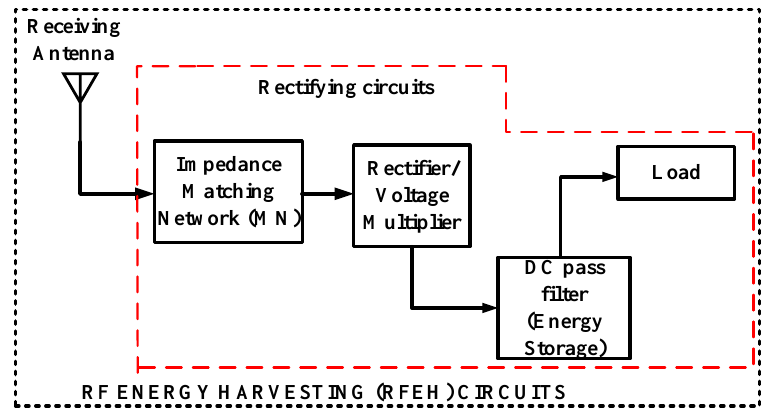
Figure 1. Block diagram of RF energy harvesting